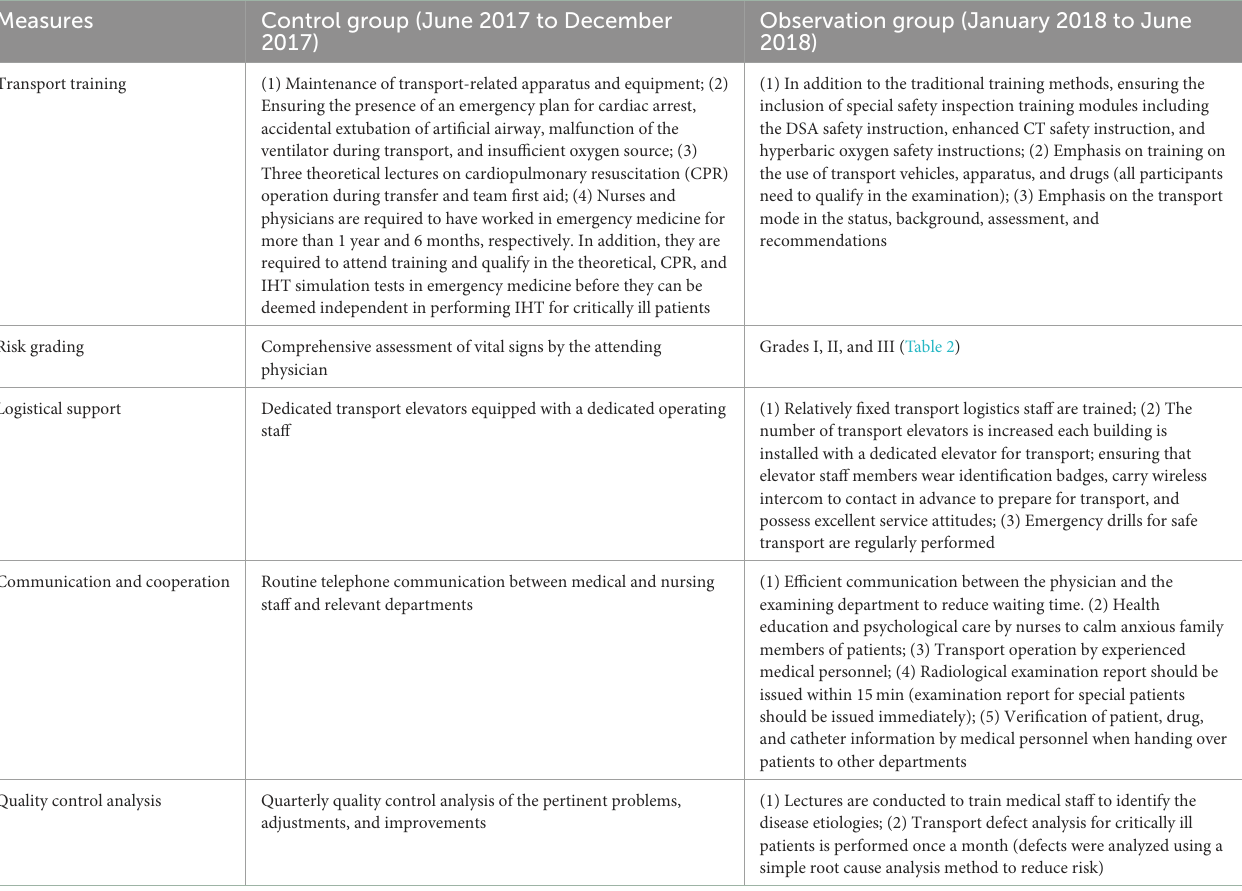
TABLE 1 Specific measures related to intrahospital transport for critically ill patients in the control and observation groups.